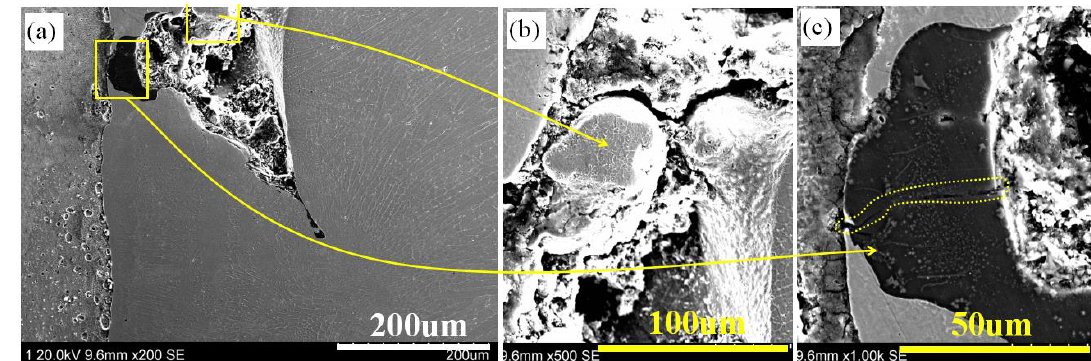
Figure 5. SEM micrographs near the defects zone: ( a ) defects near interface; ( b ) unmolten powder; ( c ) crack zone.